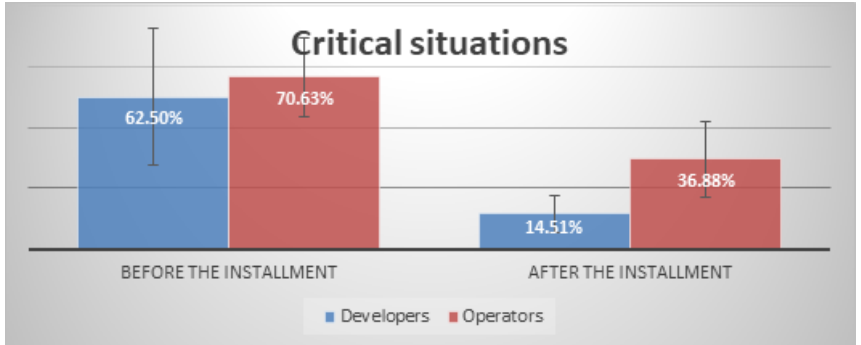
Figure 6. Perceived impact of the robotic workstation on critical situations (percentage of answers, the lines are showing the standard deviation of the answers).